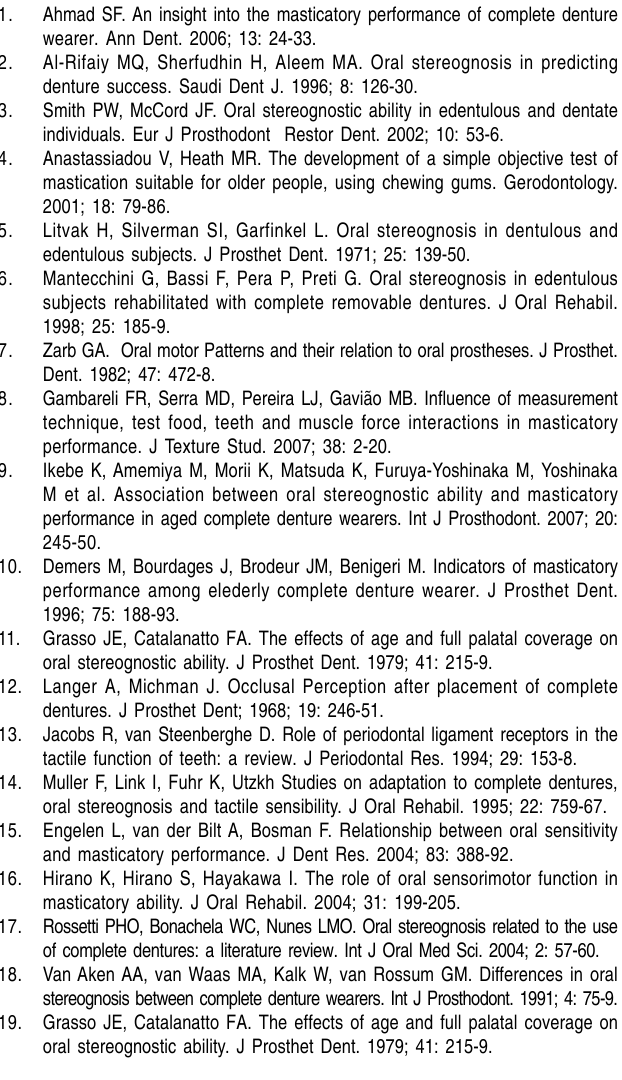
Fig. 2. Comparison between weight loss on the day 1 of denture insertion and after 6 months of denture usage. CHEW_INI: initial weight loss of chewing gum on the day 1 of denture fit and insertion CHEW_FIN: final weight loss of chewing gum after 6 months of denture